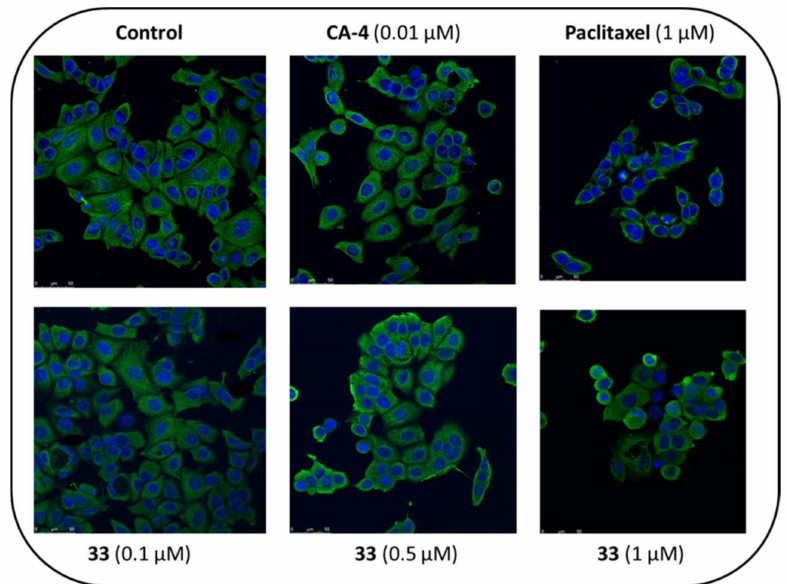
Figure 8. Compound 33 acts as depolymeriser of the microtubule network of MCF-7 breast cancer cells. Cells were treated with vehicle control (0.1% ethanol ( v / v )), CA-4 (0.01 µ M), paclitaxel (1 µ M) or compound 33 (0.1, 0.5 and 1 µ M) for 16 h. Cells were fixed in ice-cold methanol and stained with mouse monoclonal anti- α -tubulin–FITC antibody (clone DM1A) (green) and Alexa Fluor 488 dye and counterstained with DAPI (blue). Images were obtained with Leica SP8 confocal microscopy with Leica Application Suite X software, (LAS V 4.13), Wetzlar, Germany. Representative confocal micrographs of three separate experiments are shown. White scale bar indicates 50 µ